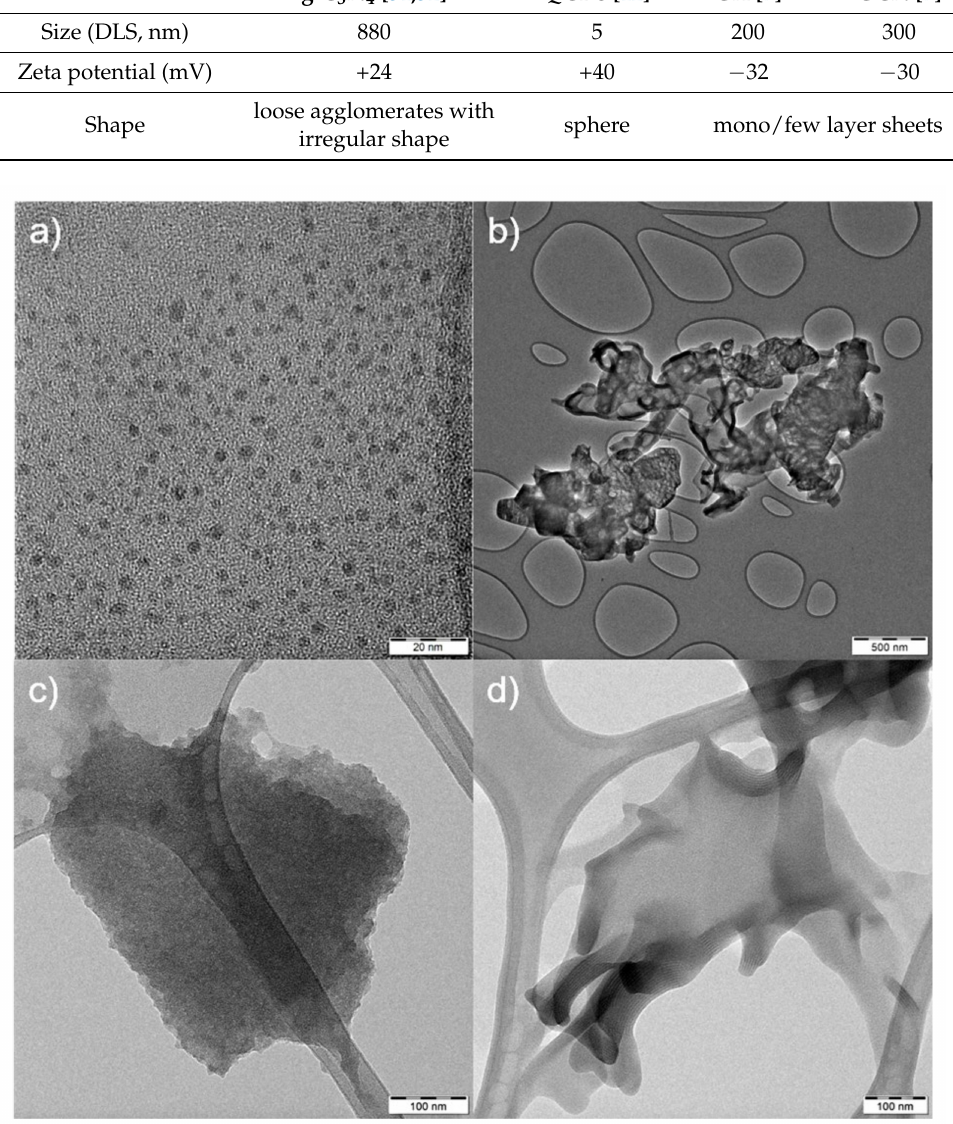
Figure 1. Transmission electron microscopy images of ( a ) QCDs (scale 20 nm); ( b ) g-C 3 N 4 (scale 500 nm); ( c ) GA and ( d ) GCN (both scales 100